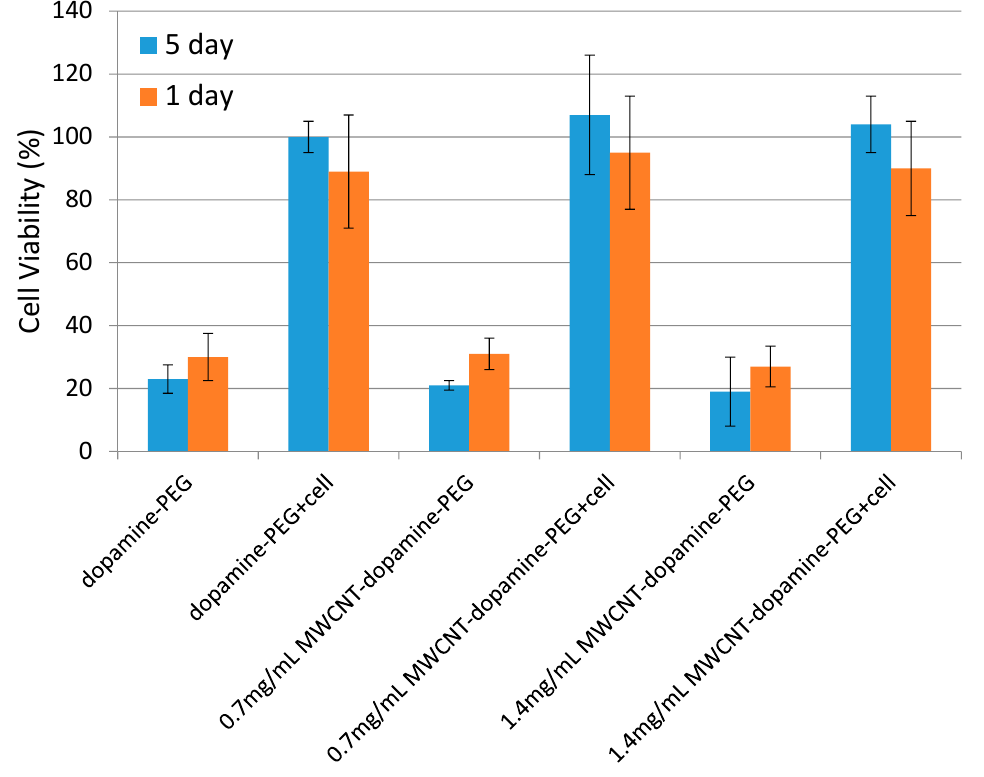
Figure 5. MTT assay of BMSCs cultured on dopamine-PEG, 0.7 mg/mL MWCNT-dopamine-PEG, and 1.4 mg/mL MWCNT-dopamine-PEG gels on day 1 and day 5.